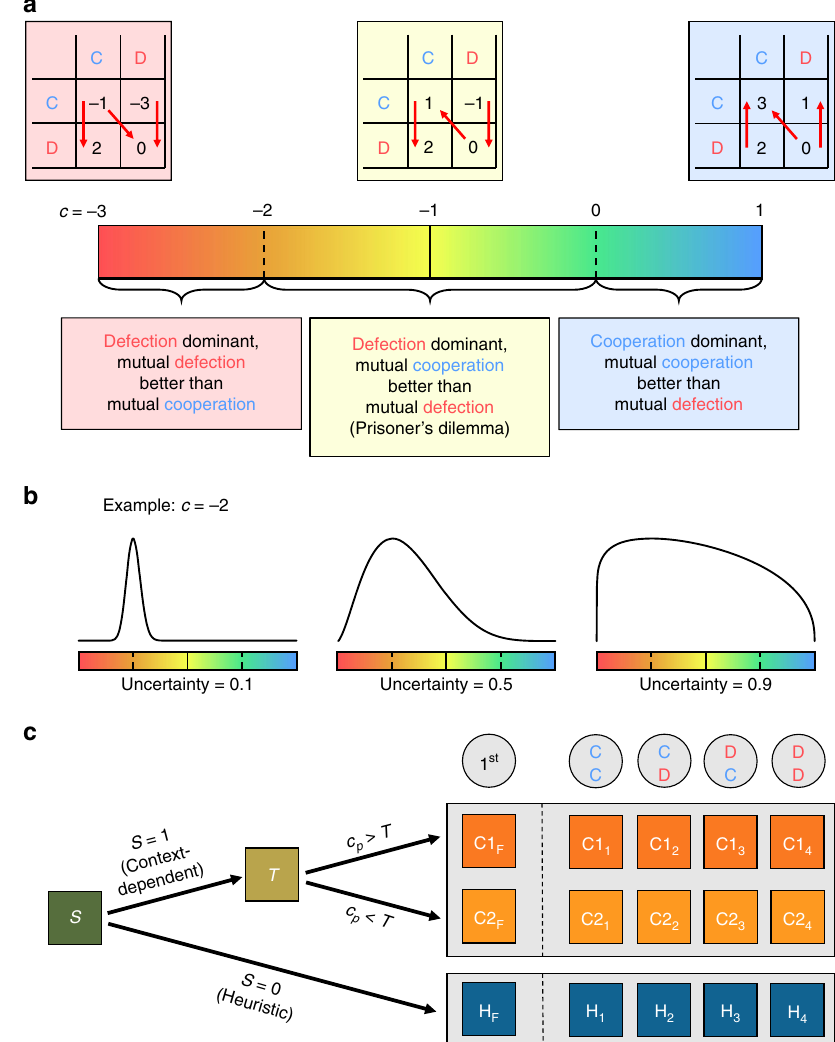
Fig. 1 Implementation of a heterogeneity in social interactions, b uncertainty about social interactions and c cooperation strategies in our simulation model. a Individuals face various social situations, always containing an element of cooperation. If an individual cooperates, she provides a fi xed bene fi t to her interaction partner ( b = 2), at a variable consequence ( c ) to herself. c can take any value between − 3 (a severe cost) and 1 (a bene fi t; horizontal bar). Payoff matrices show payoffs to the row player for the speci fi c cases where c is equal to − 3 (red), − 1 (yellow) and 1 (blue). b Uncertainty ( u ) determines how individuals perceive the value of c . Speci fi cally, this perceived value c p is drawn from a beta distribution with mode c , and variance that is proportional to uncertainty. For u = 0, the variance of the distribution is 0 ( c p = c ); for u = 1, the distribution is uniform. c Each individual carries 17 genes (indicated by squares). Gene S determines whether the individual implements a heuristic ( S = 0) or a context-dependent ( S = 1) strategy. If S = 0, the individual